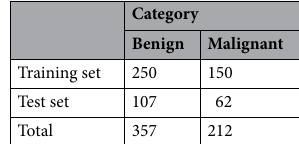
Table 4. Sample distribution